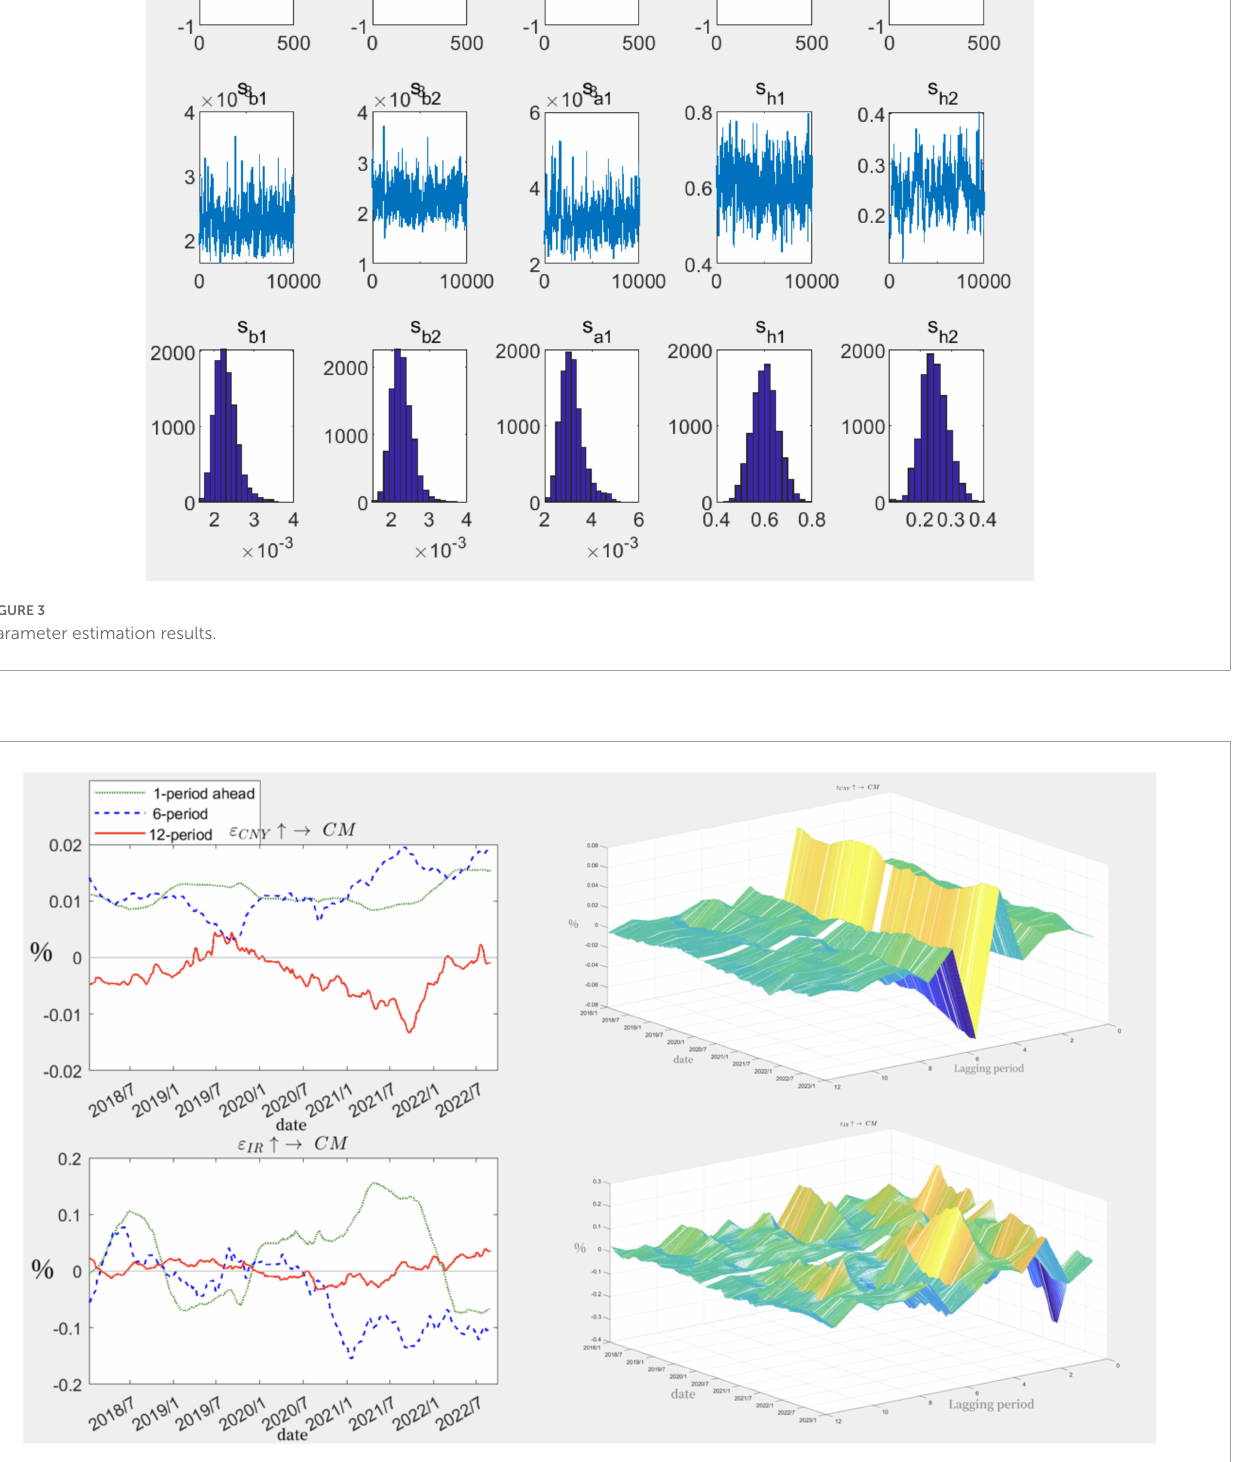
FIGURE4 Equally spaced impulse